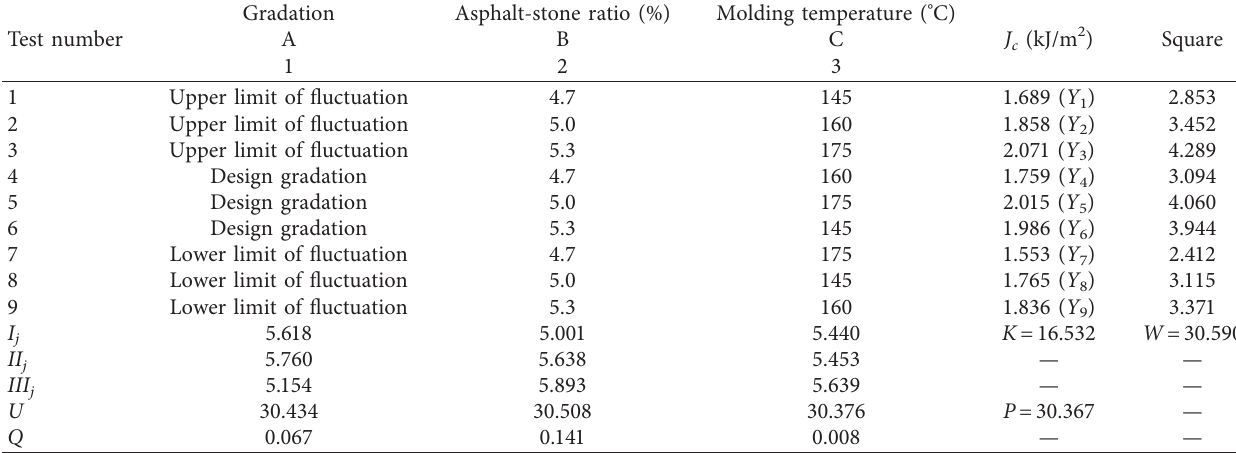
Table 11: Calculation process of variance analysis.